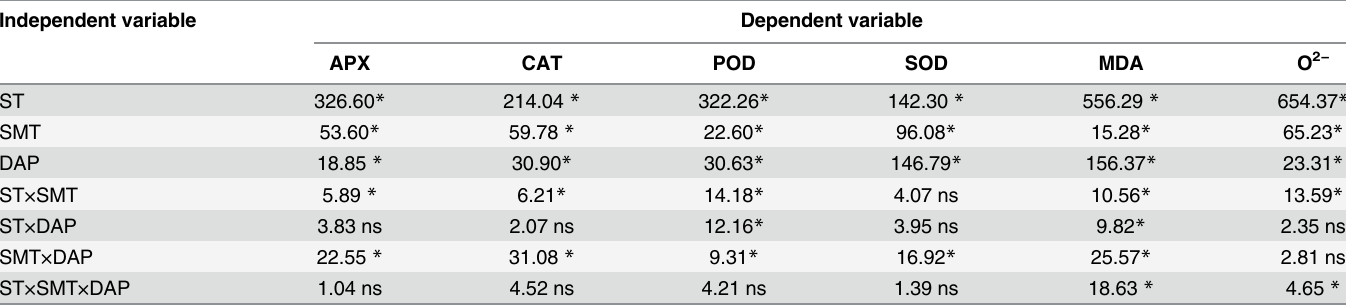
Numbers represent F-values at 0.05 probability